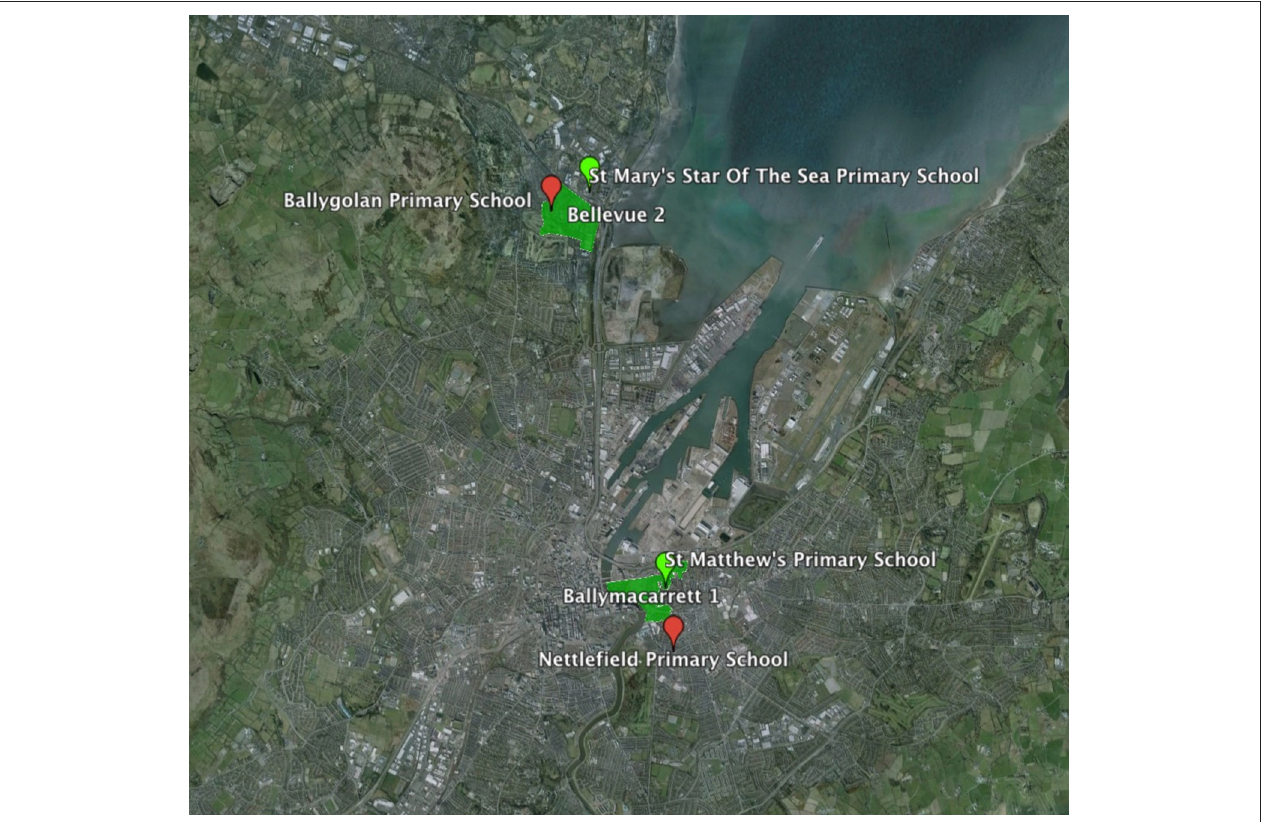
FIGURE 1 | Map of Belfast with the neighborhoods Ballymacarrett 1 and Bellevue 2 in green and the 4 primary schools used in the donations experiments before, during and after the sectarian riots. Catholic primary schools (green markers) and Protestant primary schools (red markers).